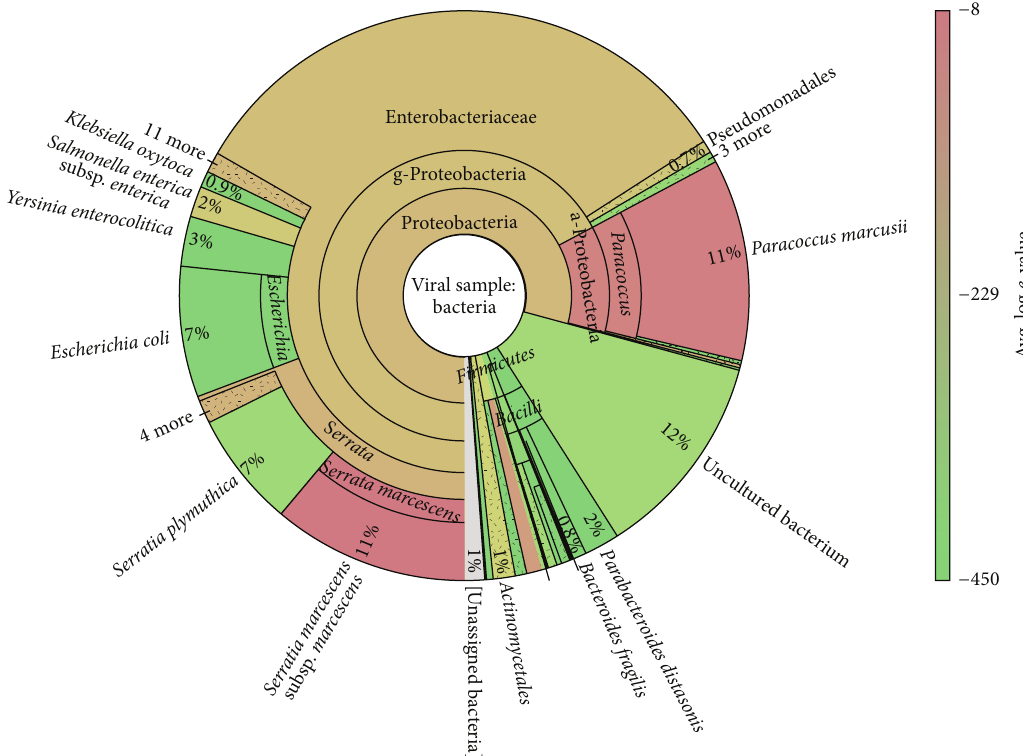
Figure 3: Bacterial taxa identified within the viral sample. Bacteria identified following de novo assembly of all unmapped reads (42.7%) from the targeted mapping approach. The Krona chart represents abundances of taxa within the 0.5 M reads corresponding to classified bacterial contigs, with abundances based on the number of reads mapping to contigs. Taxa are coloured by average contig blast log 𝑒 -value.